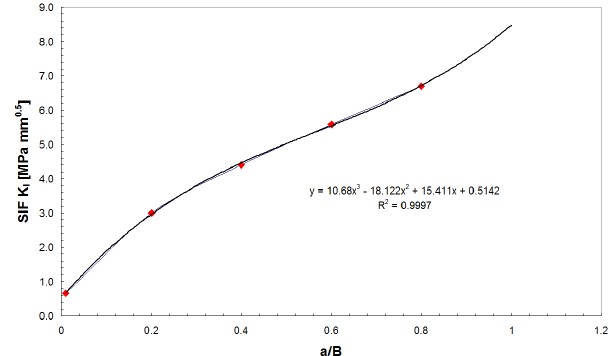
Figure 5: Trend of K I vs . a/B for deepest point of conductor’s crack.